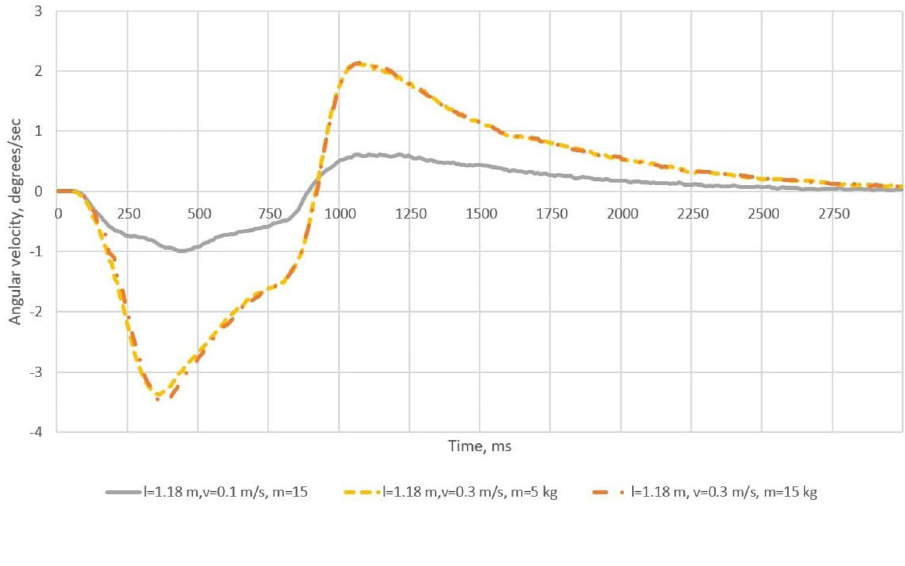
Fig. 7 Angular velocity of the rope